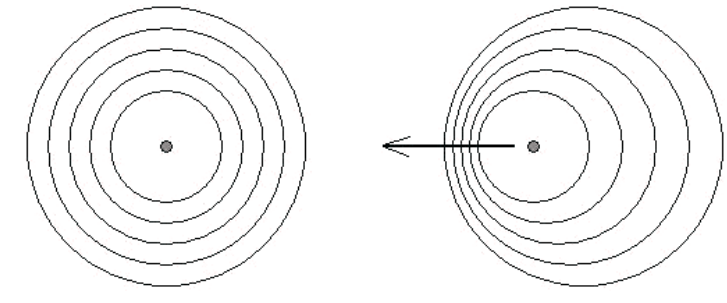
Fig. 5. Propagation of space curvature